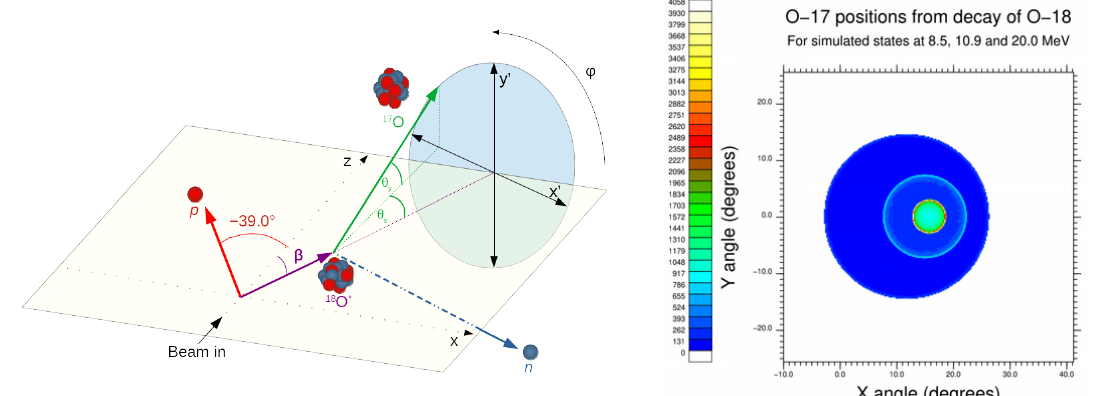
Figure 2: A diagram depicting the total reaction 12 C( 7 Li, p ) 17 O + n , showing the area in which the 17 O is constrained (a cross-sectional slice of the kinematic cone) due to detection of the proton within the angular acceptance of the Q3D (left). Also shown are Monte Carlo data, generated for three different 18 O excitation energies, showing the increase in the radius of these kinematic cones for an increase in excitation energy